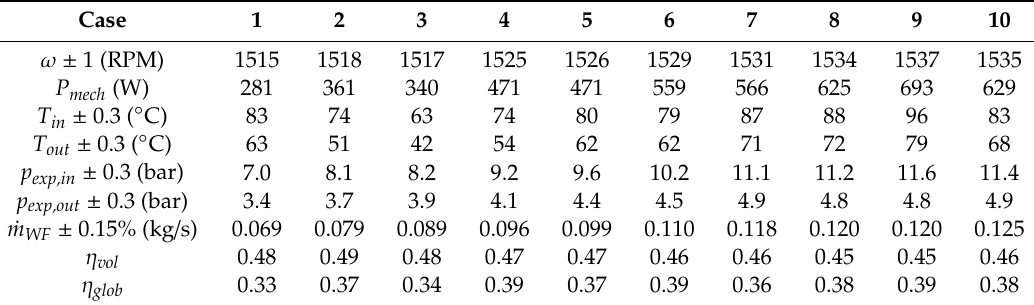
Table 4. Experimental characterization of the expander when η vol =